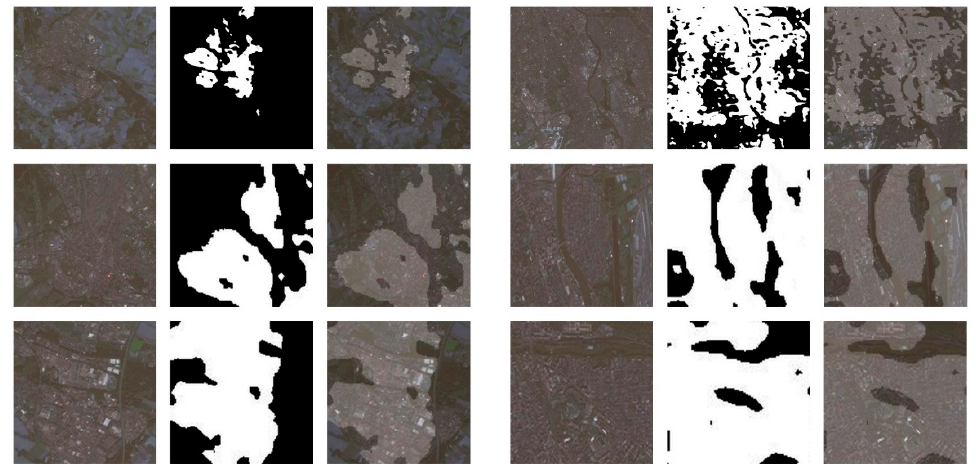
Figure 11. Experimental results on the Gaofen 16 m validation set.